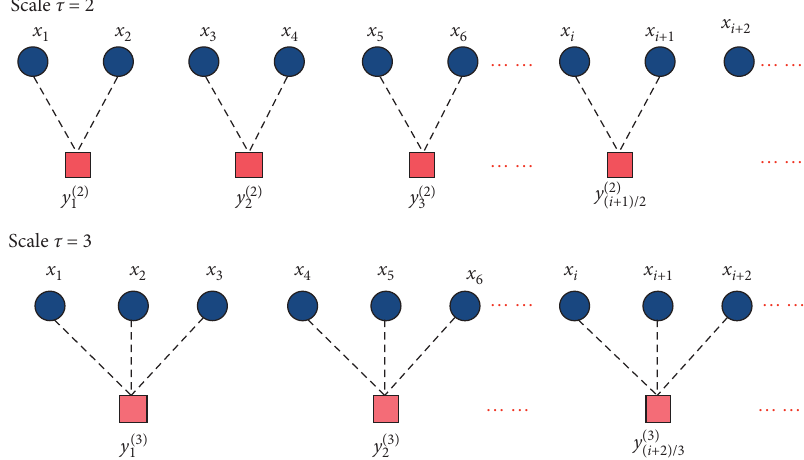
Figure 4: Exhibition of coarse-graining procedure for scale factor τ � 2 and τ � 3.